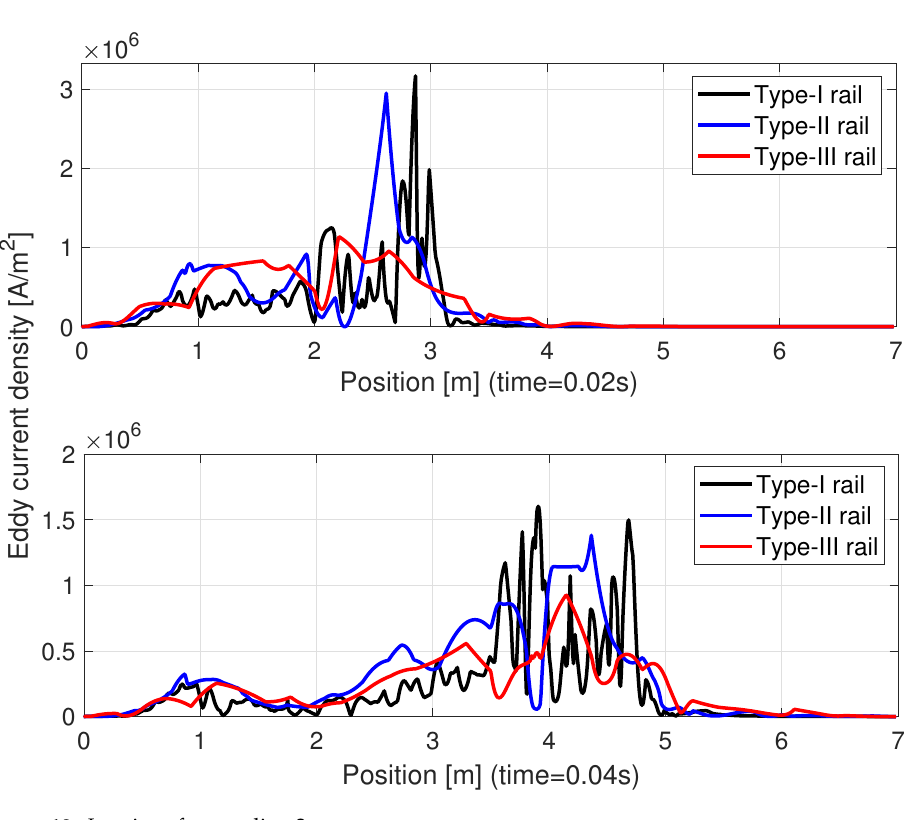
Figure 19. J mag in reference line